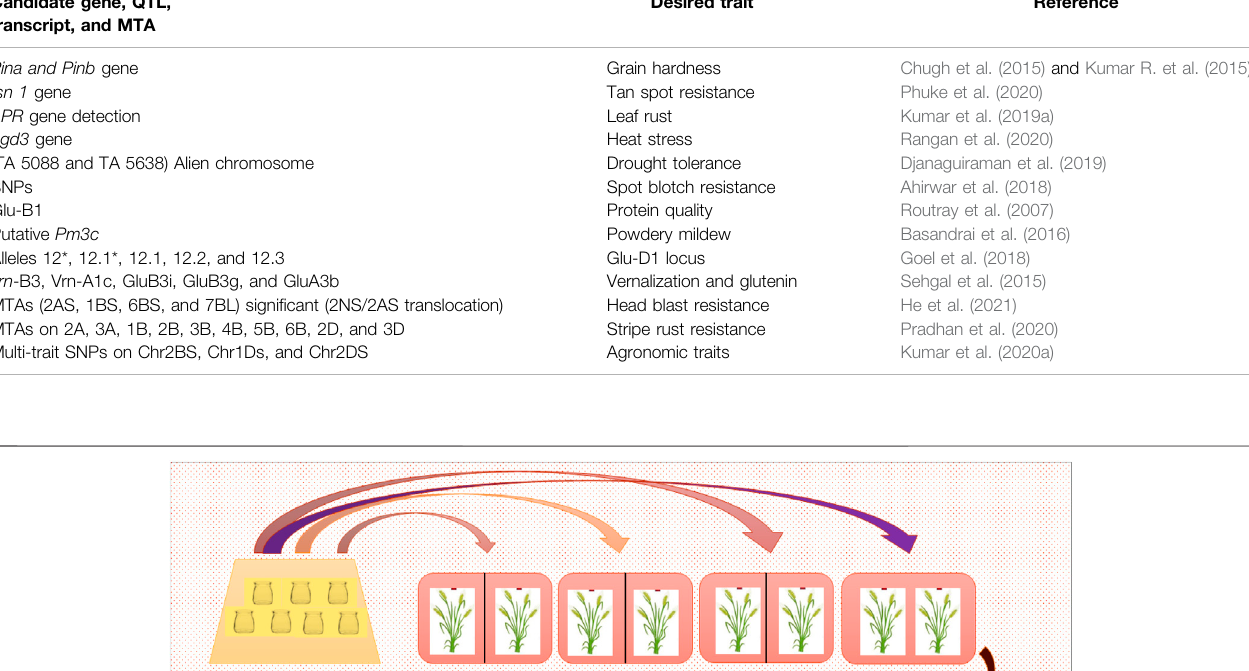
TABLE 3 | Identi fi ed candidate gene/transcripts, QTL, and MTA, etc., from Indian wheat germplasm. Candidate gene, QTL, transcript, and MTA